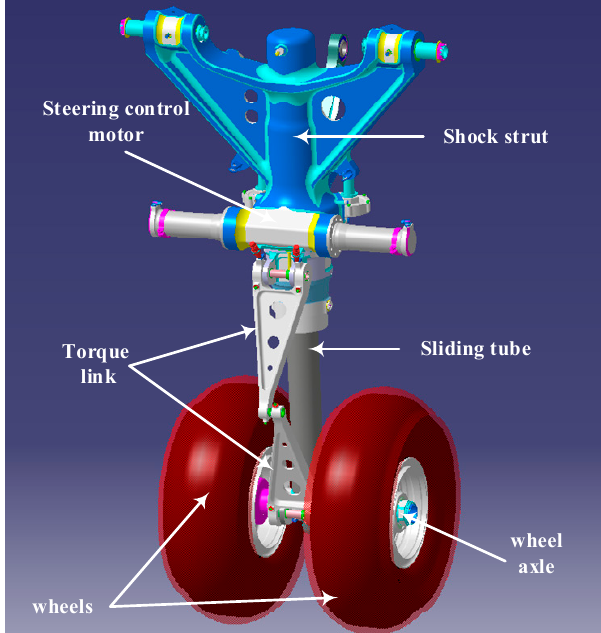
Figure 6. The structure of the wheel steering system.